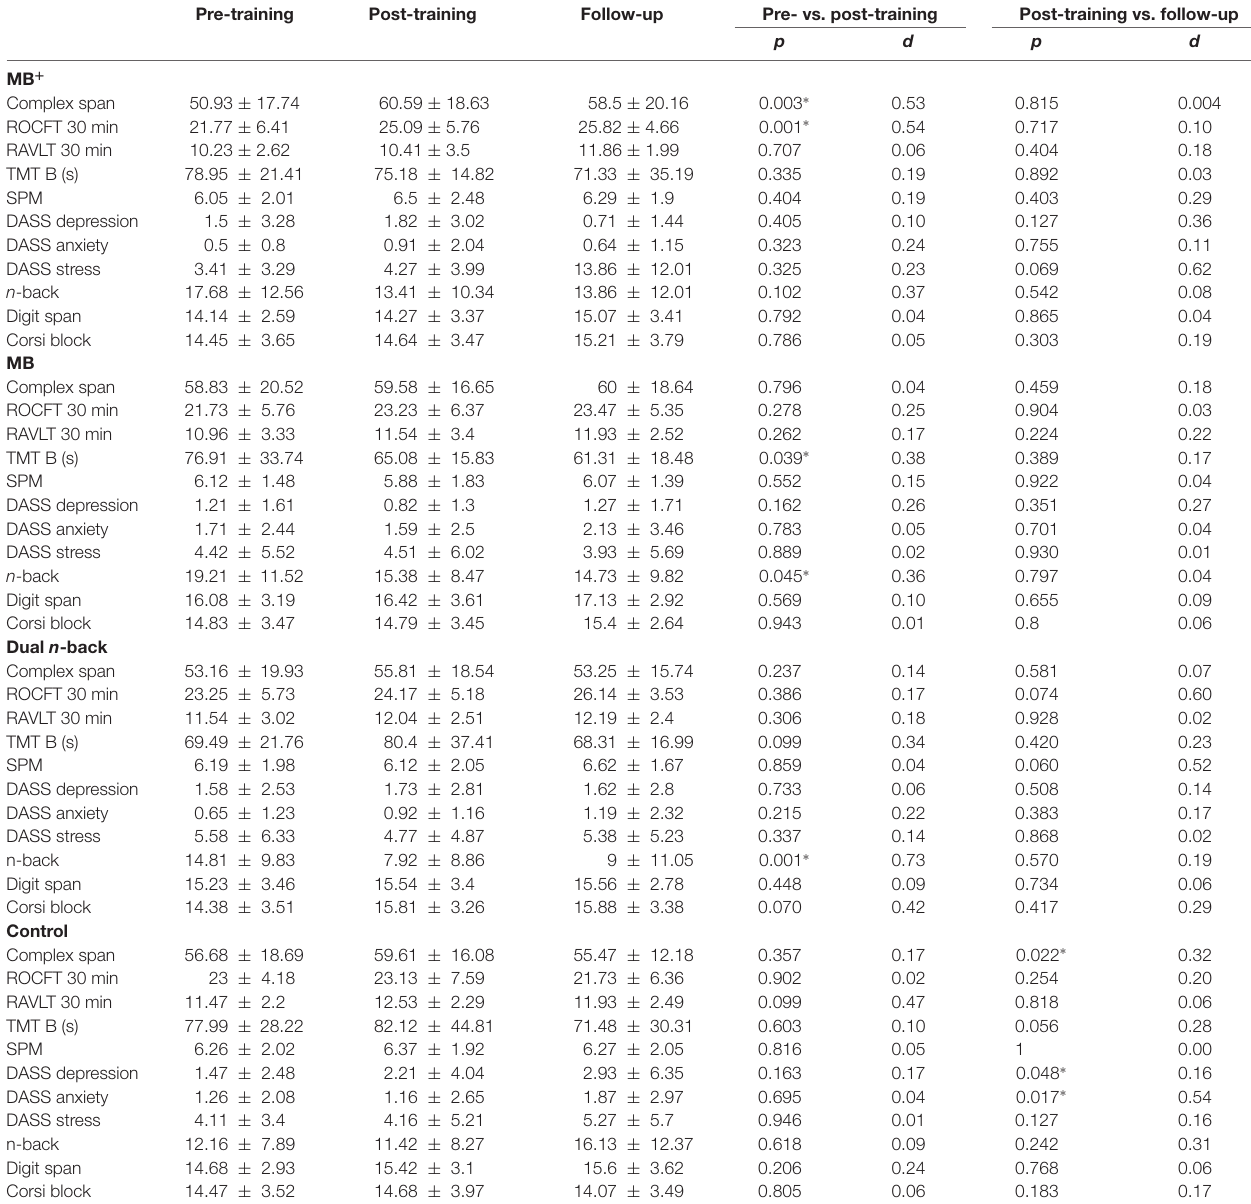
TABLE 4 | Means, standard deviations, and univariate comparisons of the neuropsychological assessment at each session for each group. Pre-training Post-training Follow-up Pre- vs. post-training Post-training vs.